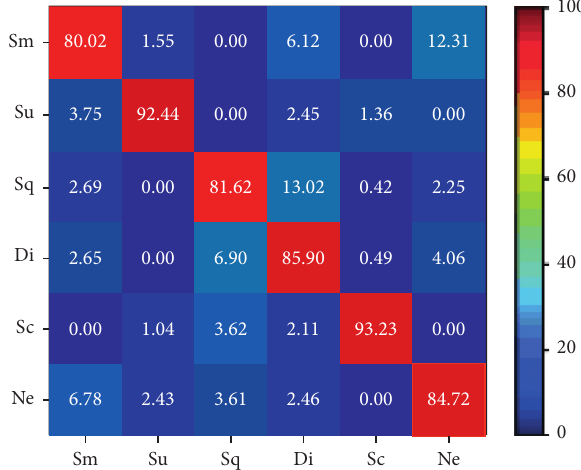
Figure 11: The confusion matrices on CMU Multi-PIE dataset.